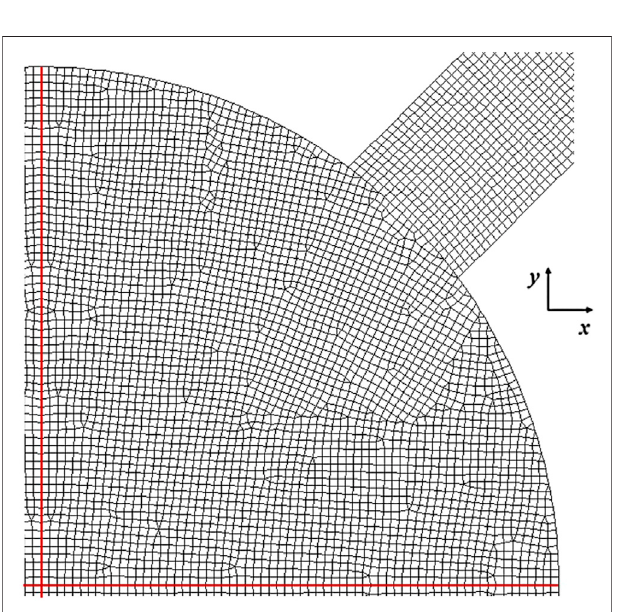
FIGURE 4 | Meshing in a quart of one NETmix